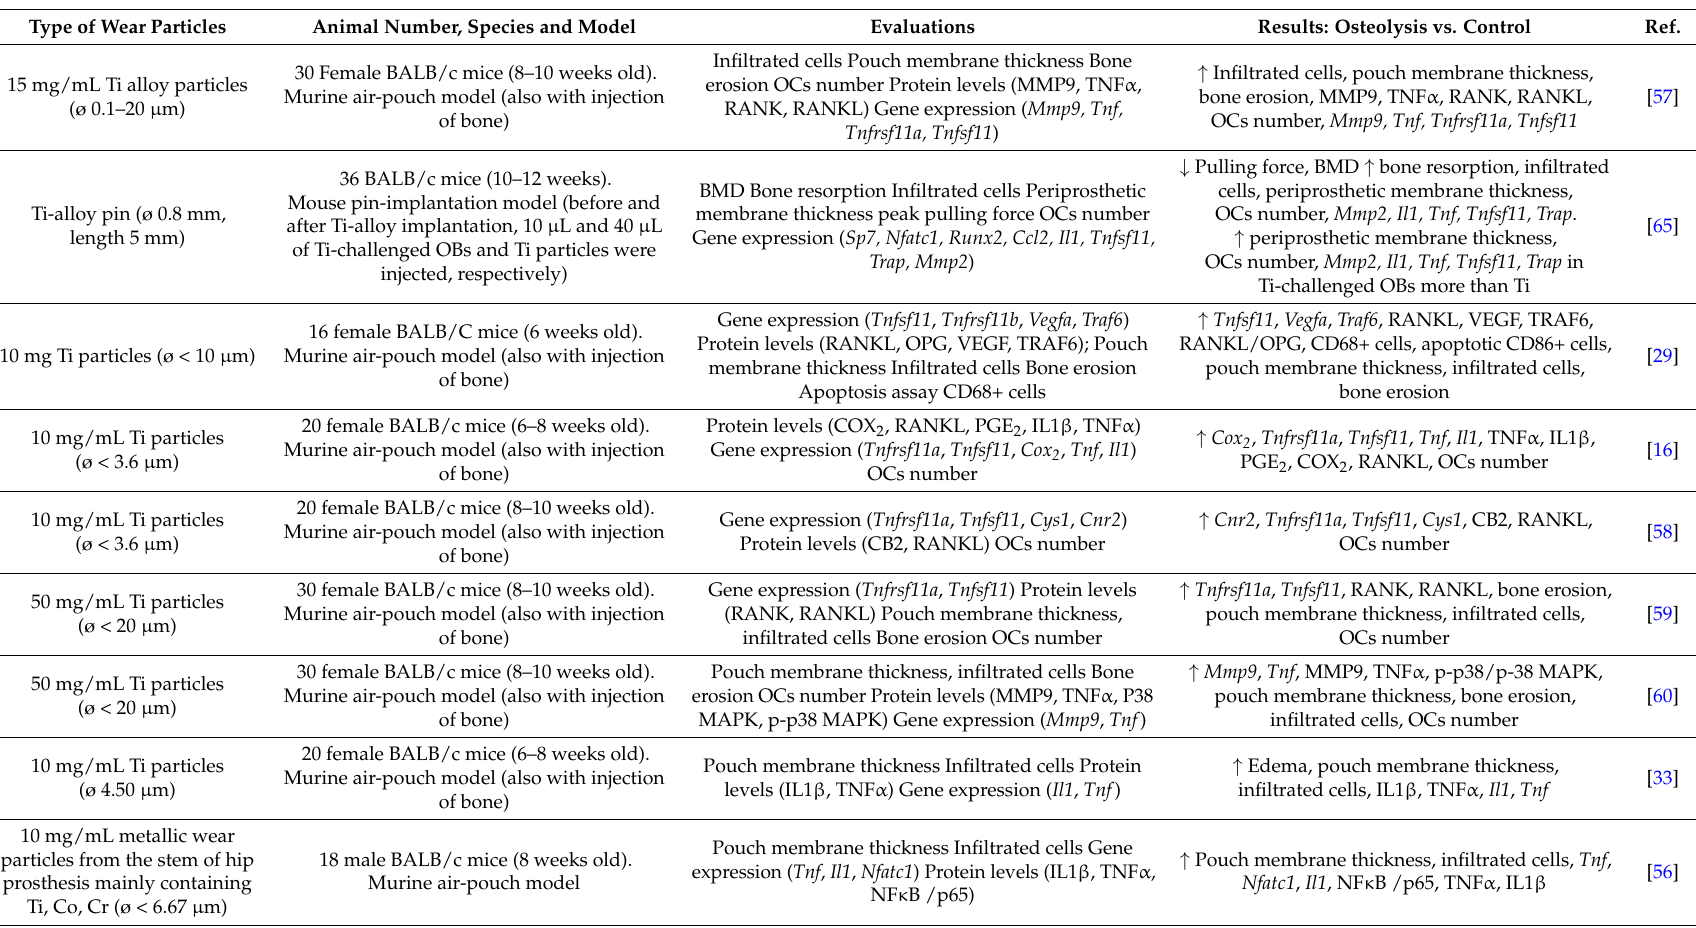
Table 2. In vivo